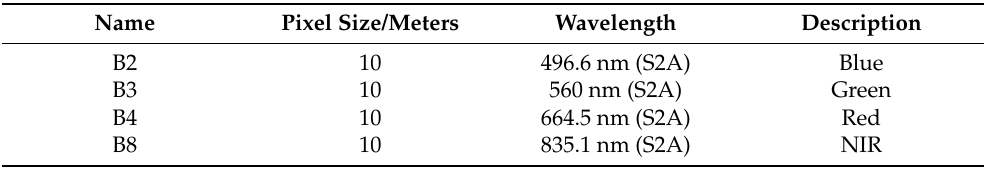
Table 1. Main parameters used in this paper of the Sentinel-2 sensor.